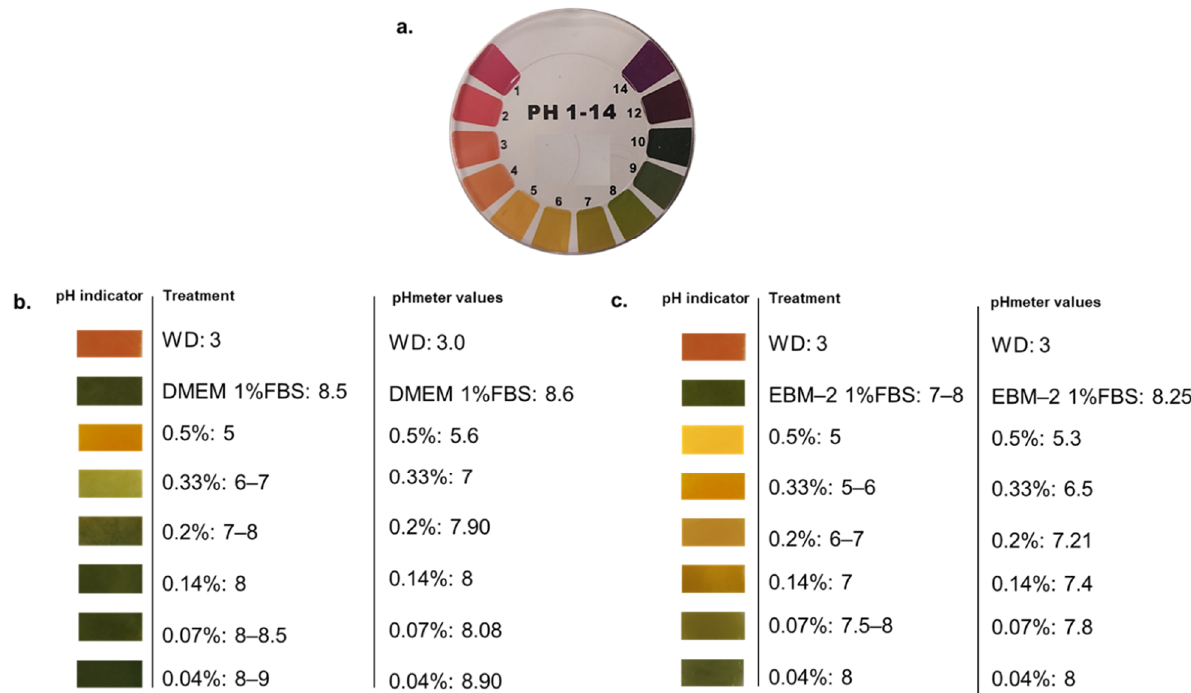
Figure 1. Measurement of pH in cell culture media containing diluted WD. ( a ) The litmus test was applied using 50 µL of each solution on litmus paper, and a colour comparison was used to approximately evaluate pH level. A CyberScan pH 510 meter (Thermo Scientific, Eutech instruments, Malaysia) was used to confirm the data. ( b ) pH of WD dilutions in DMEM containing 1% FBS, used to treat HaCaT, A431tumor cells and NHDF. ( c ) pH of WD dilutions in EBM-2 containing 1% FBS, used to treat HUVEC.